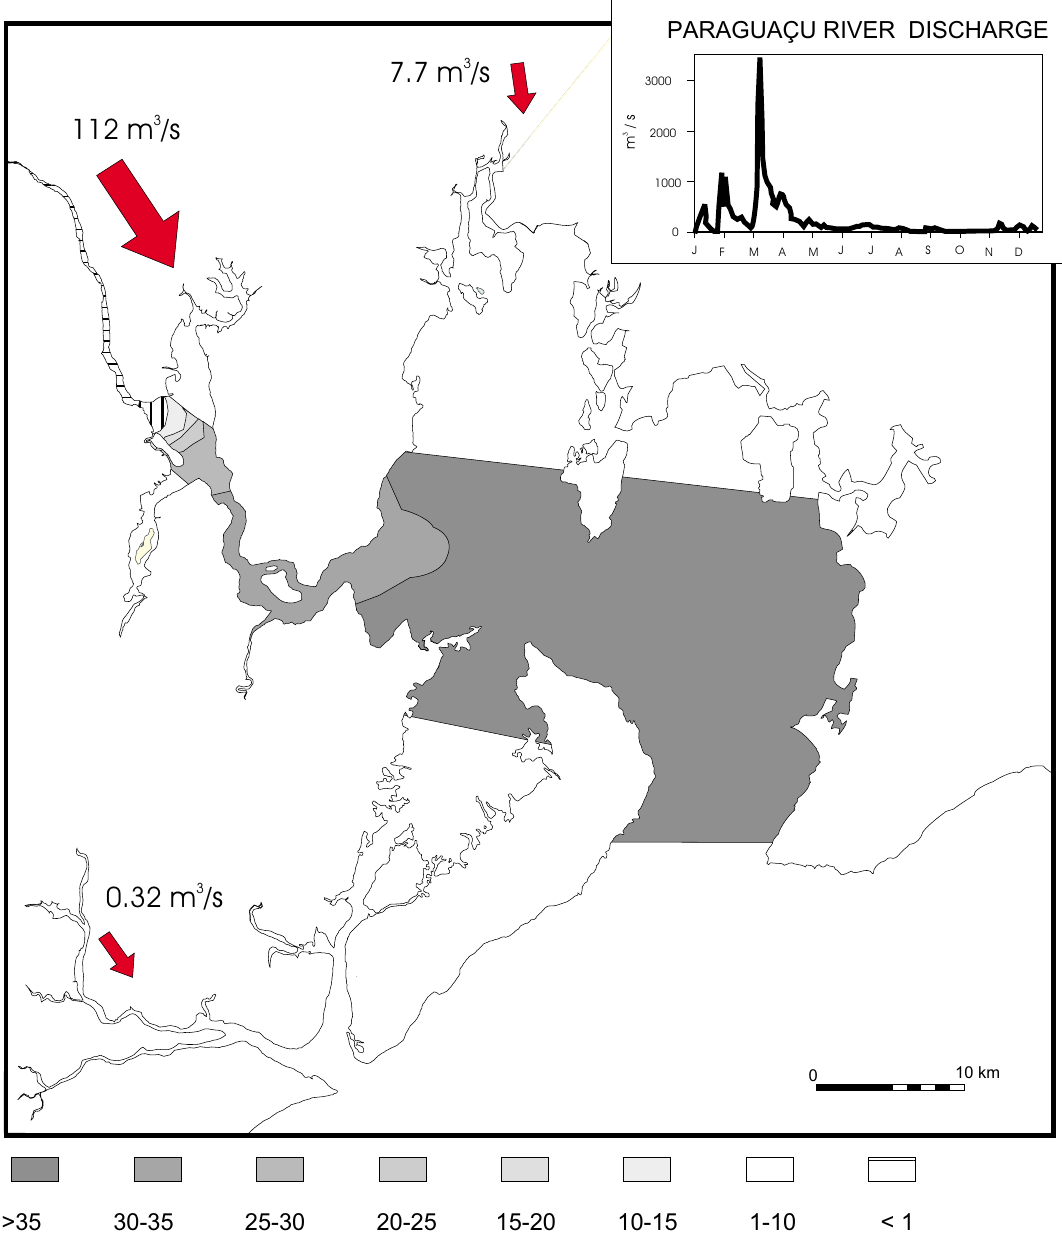
Fig. 2 – Salinity distribution during a cruise in May 1977 with fresh water discharge from Paraguaçu River at around 40 m 3 /s (after Wolgemuth et al. 1981), average freshwater discharge into the bay (prior to the dam construction in 1985) and the variation of fresh water discharge from the Paraguaçu River during 1960